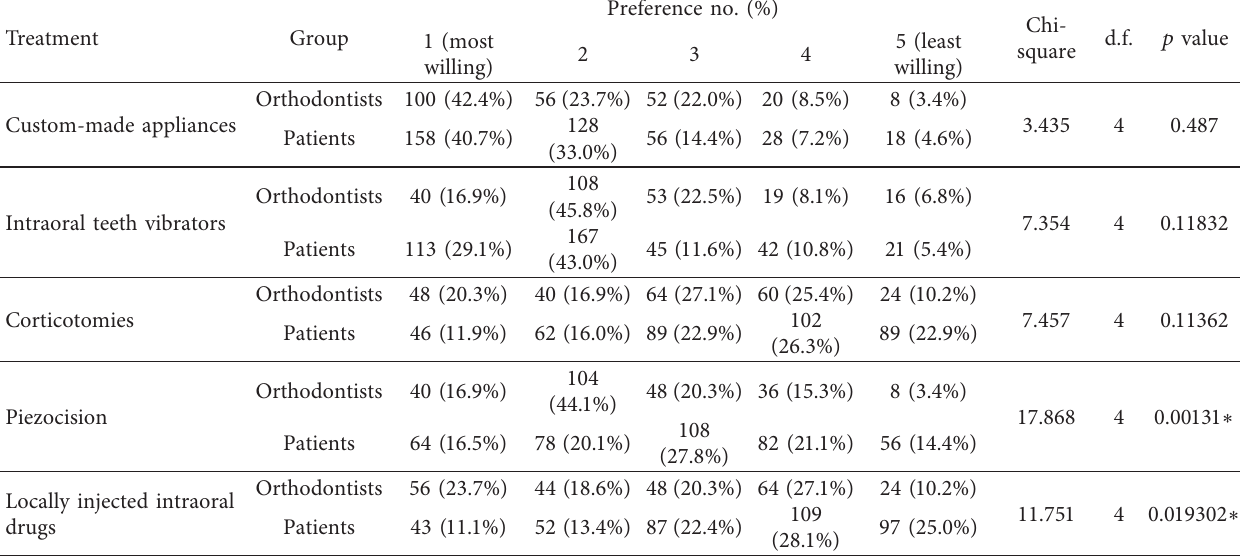
Table 4: Preference for different procedures for a 25% to 30% reduction in treatment time.